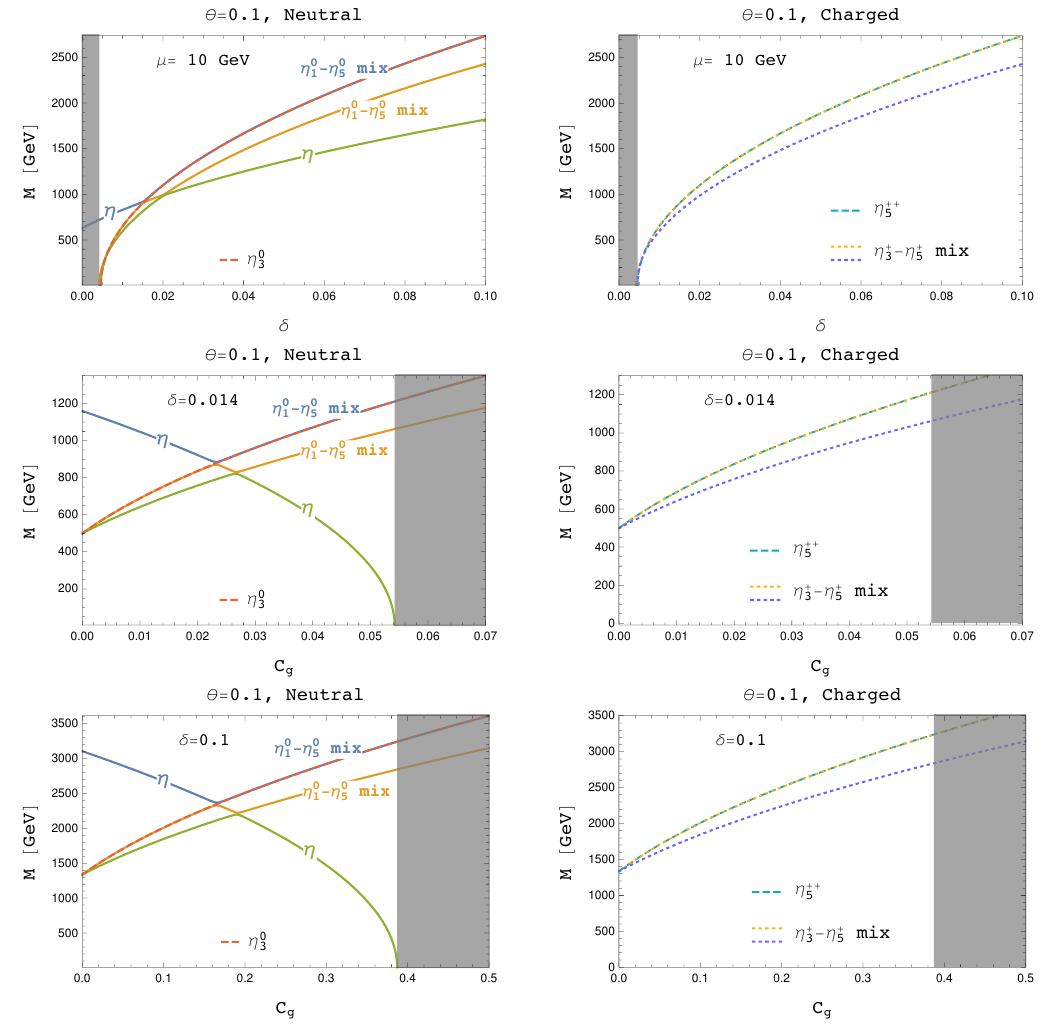
Figure 5 . Masses of the neutral and charged pNGBs in the A L - D R case. In the top panels (cid:22) = 10 GeV, and we plot the masses against (cid:14) , while in the middle and bottom panels we (cid:12)x (cid:14) = 0 : 014 and 0 : 1, and plot the masses against C g . Note that the pattern remains unchanged for di(cid:11)erent values of (cid:14)